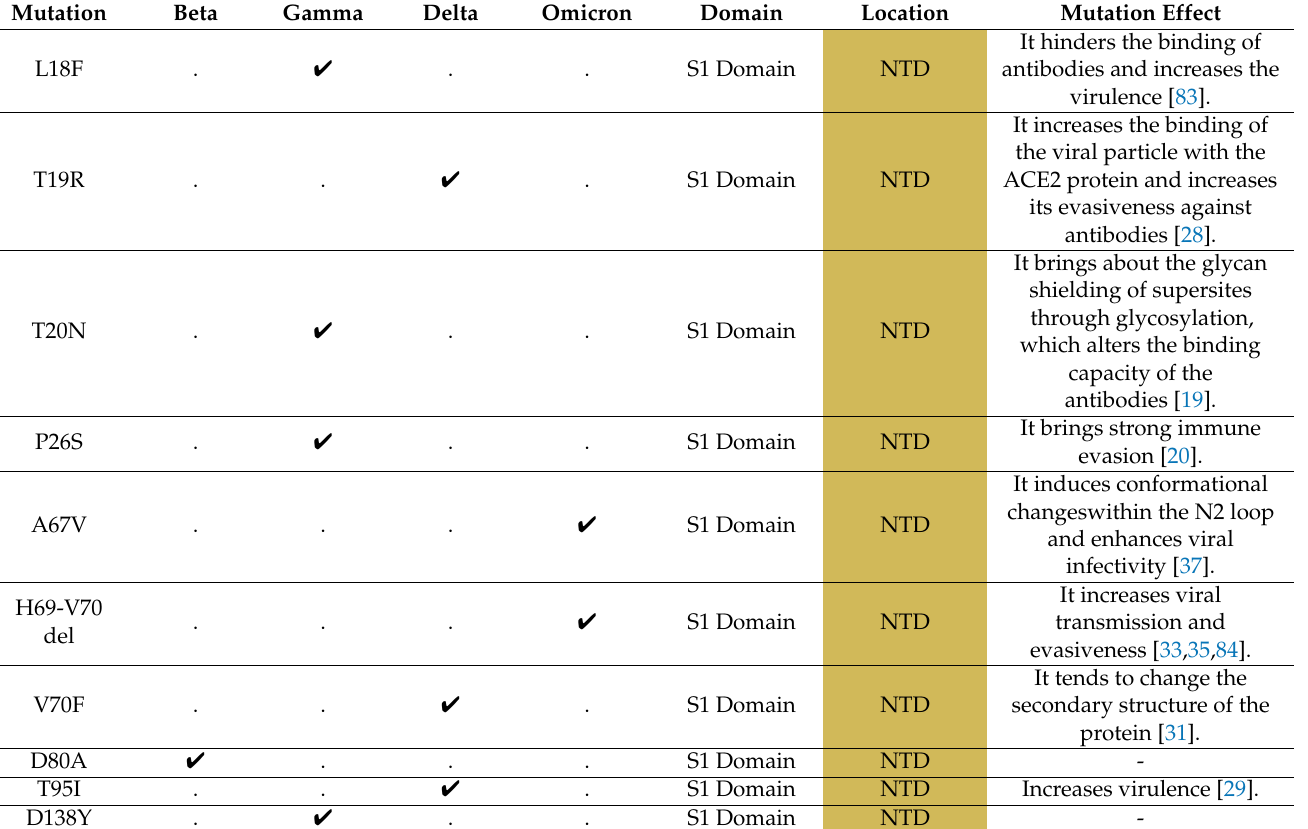
Table 1. Summary of mutations in major strains of SARS-CoV-2 and their subsequent effect. These color scheme indicates different regions in spike